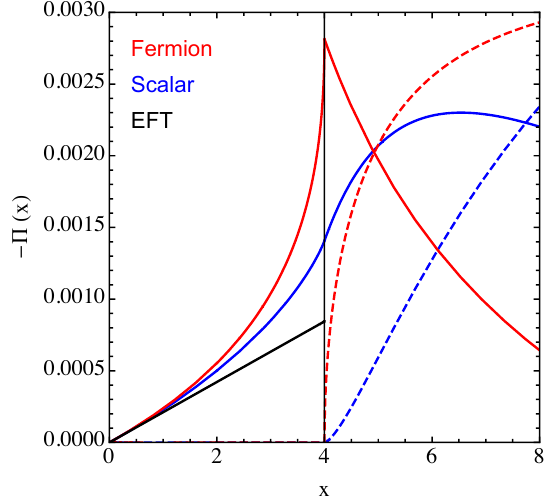
Figure 1 . Kinematical dependence of the form factor for fermions (red) and scalars (blue) running in the loop, and in the EFT limit (black). Full and dashed lines denote respectively real and imaginary part of the form